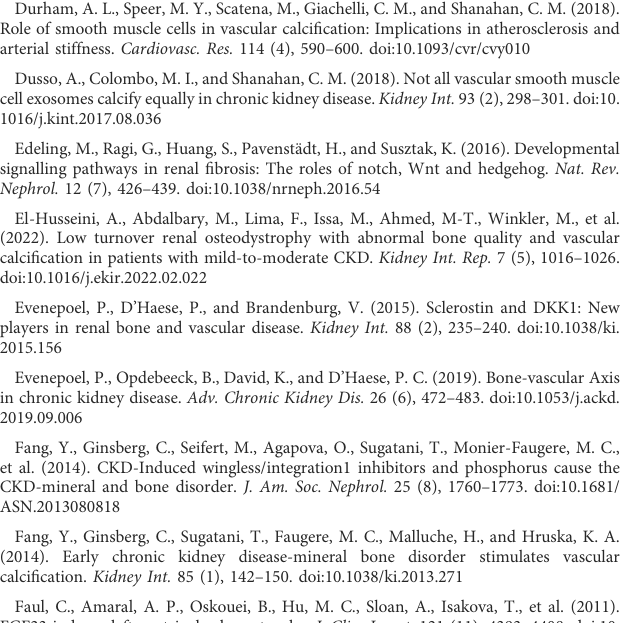
Figurek, A., Rroji, M., and Spasovski, G. (2020). Sclerostin: A new biomarker of CKD – MBD. Int. Urology Nephrol. 52 (1), 107 – 113.